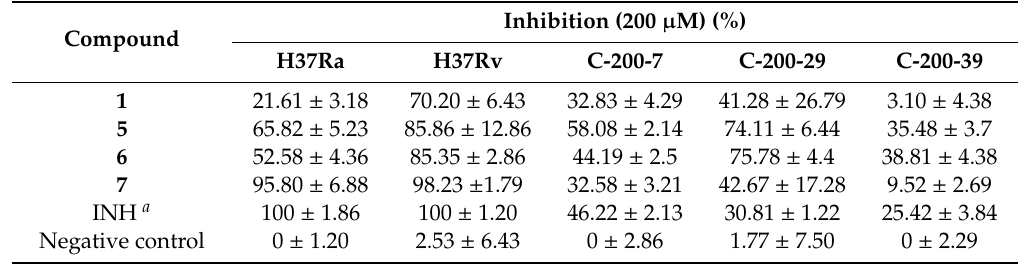
Table 3. The inhibitory activities of the compounds against sensitive and clinically isolated MDR strains. Compound